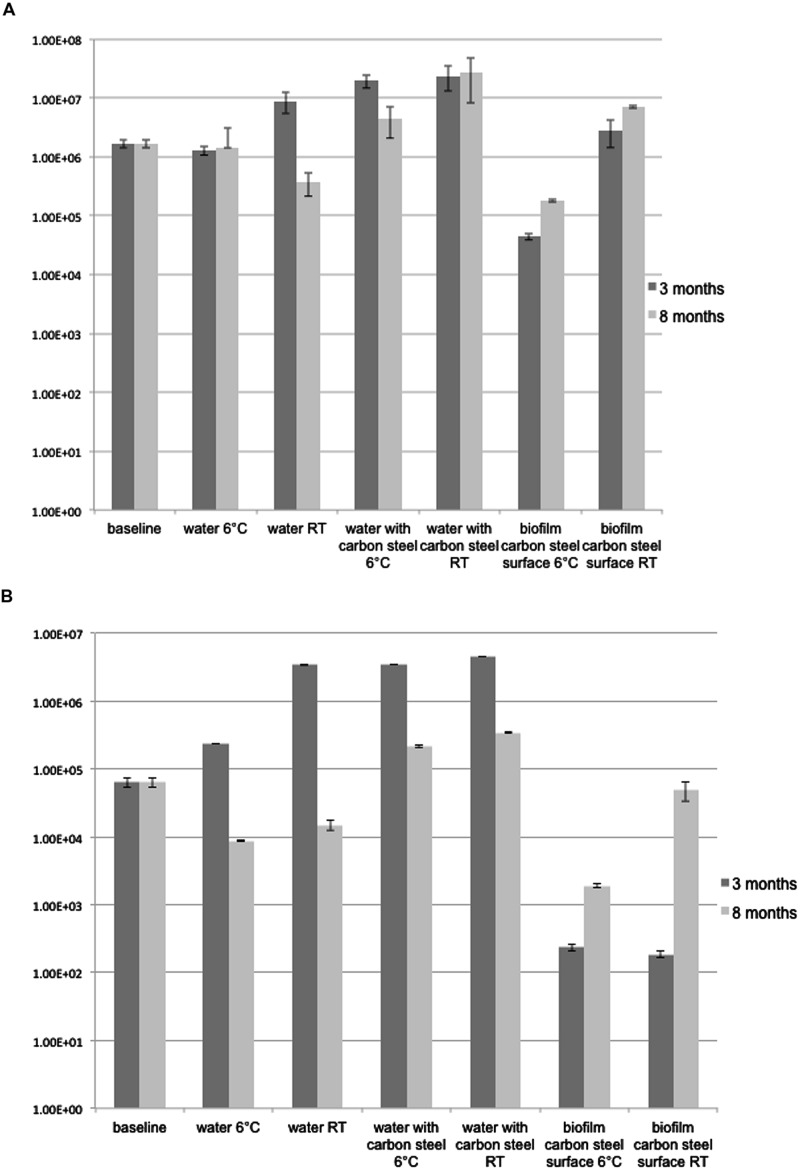
(A) 16S rRNA gene copies ml-1 groundwater or carbon steel (cm2)-1. The error bars present SE of mean (n = 3). (B)
dsrB gene copies ml-1 groundwater or carbon steel (cm2)-1. The error bars present SE of mean (n = 3).